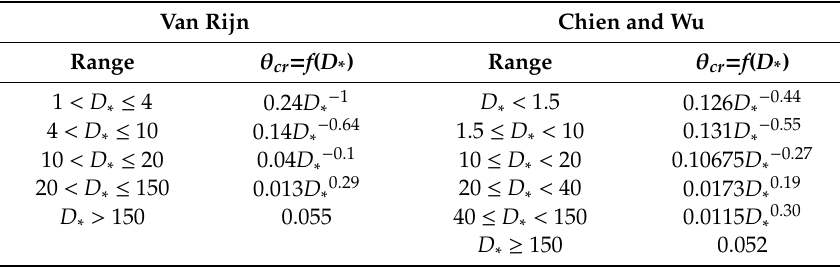
Table 1. Critical bed shear stress values, depending on the grain size parameter.